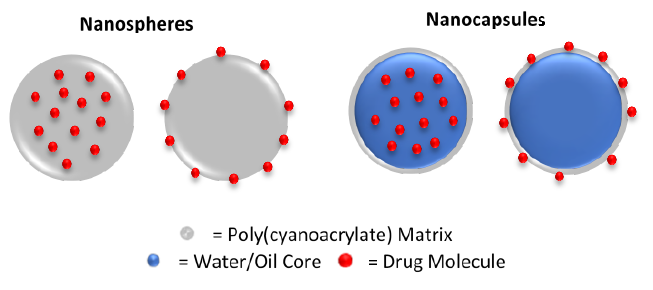
Figure 2. Types of nanoparticles.